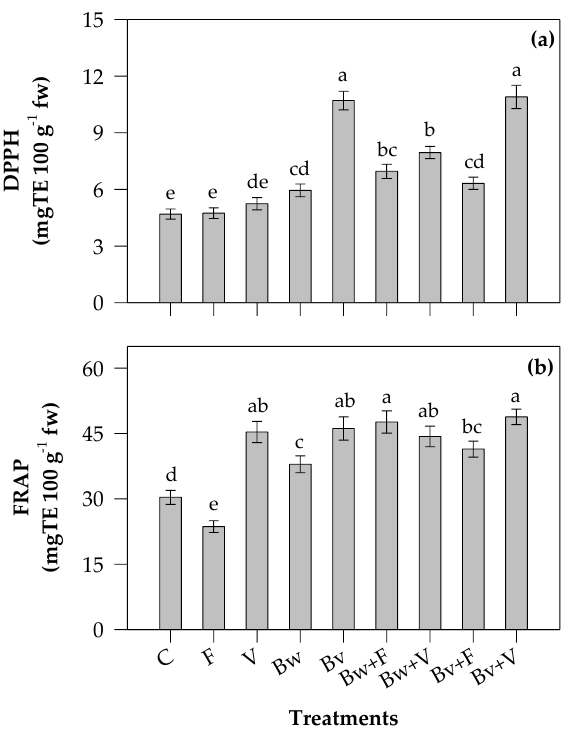
Figure 3. Antioxidant activity tested by the 2,2-diphenyl-1-picrylhydrazyl content (DPPH, mg TE 100 g − 1 fw) ( a ) and reducing power (FRAP, mg TE 100 g − 1 fw) ( b ) of Swiss chard leaves. C, control; F, ammonium nitrate; V, vermicompost; Bw, biochar from wood chips; Bv, biochar from vine prunings; Bw+F and Bv+F, biochars respectively mixed with ammonium nitrate; Bw+V and Bv+V, biochars respectively mixed with vermicompost. Values are means (n = 4) ± s.e. Different letters above histograms indicate significant differences among treatments ( p ≤ 0.05; Tukey’s test) .